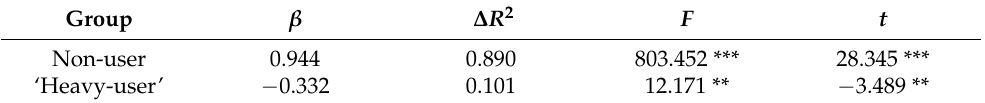
Table 4. Predicting HbO increase for the ‘non-user’ and ‘heavy-user’ groups in BA 9.